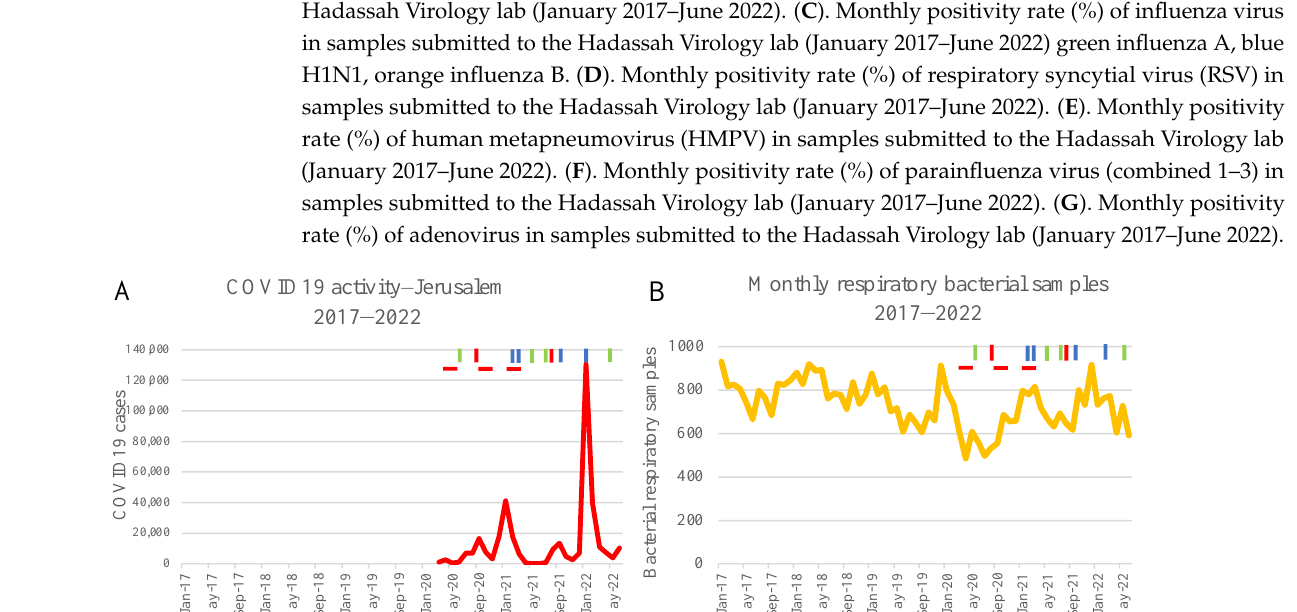
Figure 1. Viral pathogens in the pre-COVID-19 and during the COVID-19 pandemic. ( A ). COVID-